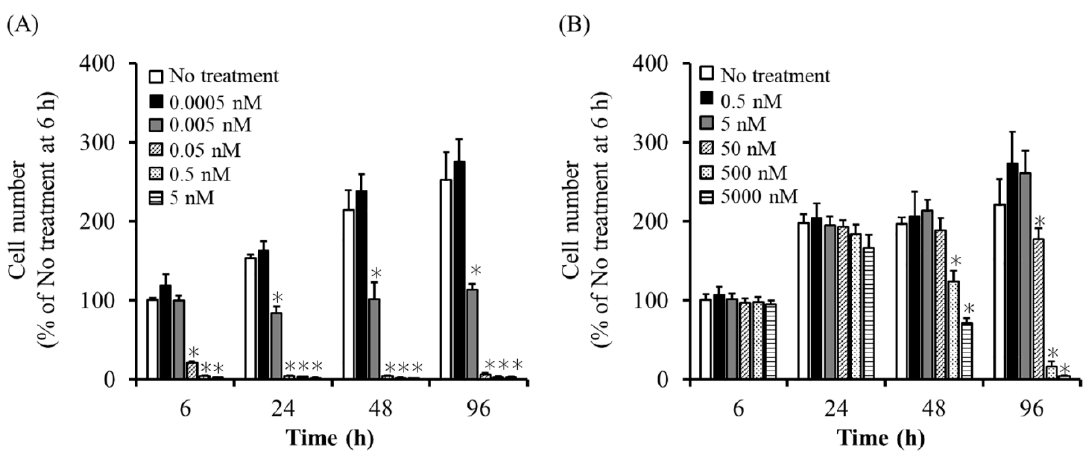
Figure 2. Sensitivity of UE7T-13/iC9 cells or UE7T-13/HSVtk cells to AP20178 or ganciclovir (GCV), respectively. ( A ) The viability of UE7T-13/iC9 cells cultured with AP20187 at various concentrations. Cells were cultured in medium containing various AP20187 concentrations. Results are expressed as the mean ± SD of three to four samples. A representative of three independent experiments with similar results is shown. * p < 0.05; statistically significant differences observed in comparison with the no-treatment group. ( B ) The viability of UE7T-13/HSVtk cells cultured with GCV at various concentrations. Cells were cultured in medium containing various GCV concentrations. Results are expressed as the mean ± SD of four samples. A representative of three independent experiments with similar results is shown. * p < 0.05; statistically significant differences observed in comparison with the no-treatment group.